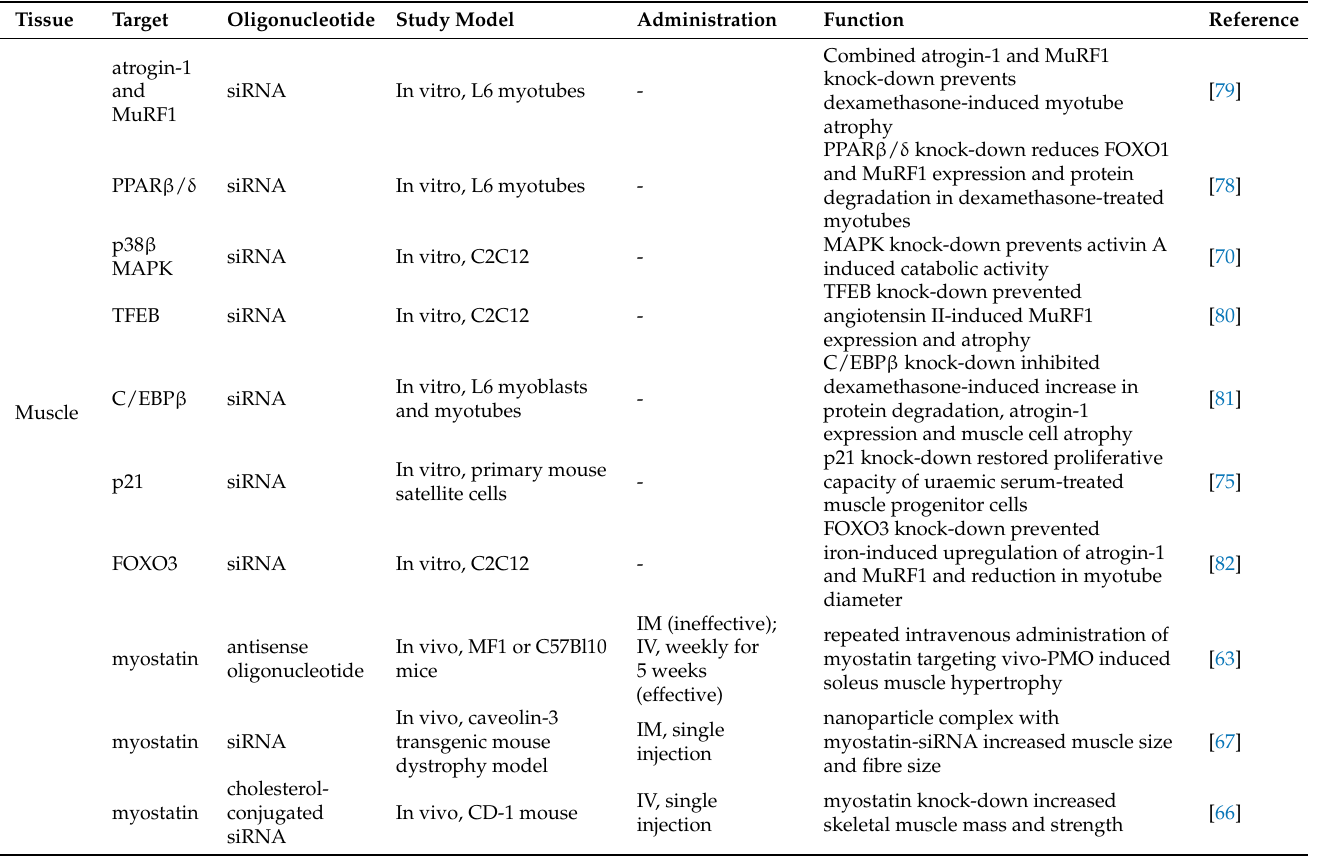
Table 1. Oligonucleotide targeting in muscle, bone, synovium, and cartilage